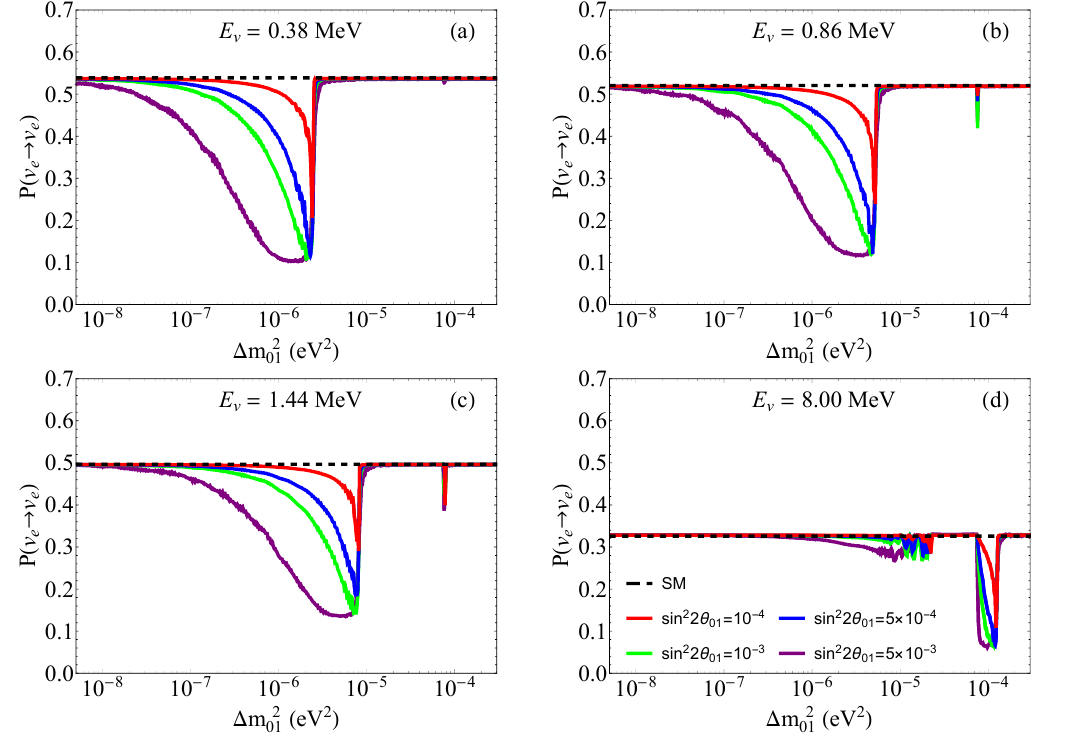
Figure 4 . Dependence of the survival probability on ∆ m 2 with different sterile mixing angle. The 01 horizontal dashed line is the survival probability in the 3 ν case. The colored curves correspond to different value of sin 2 2 θ 01 : 1 × 10 − 4 (Red), 5 × 10 − 4 (Blue), 1 × 10 − 3 (Green), and 5 × 10 − 3 (Purple), respectively. Other oscillation parameters not shown are the same as those in figure